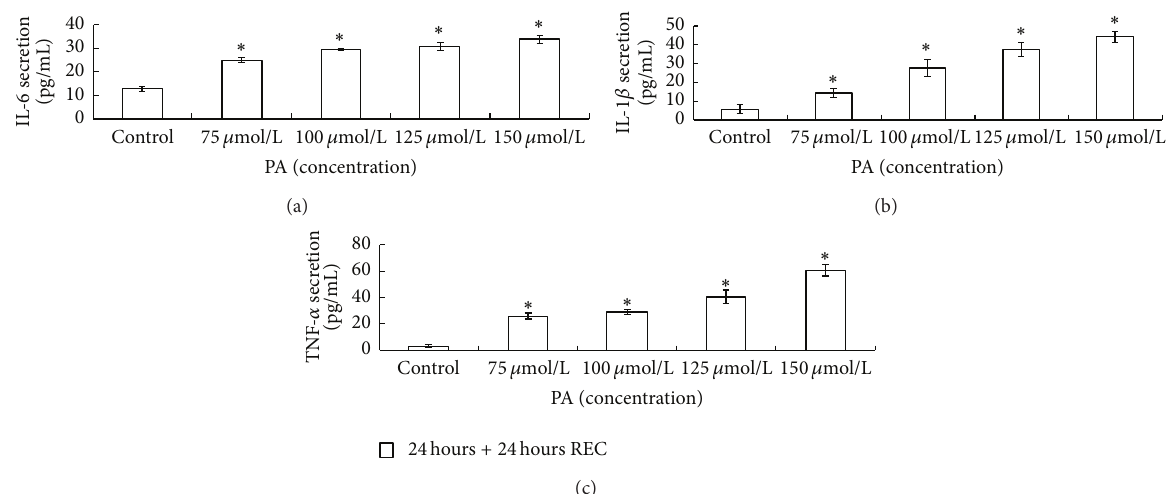
Figure 1: PA induces an upregulation of IL-6, IL-1 𝛽 , and TNF- 𝛼 secretion in HaCaT keratinocytes. HaCaT keratinocytes were untreated or treated with PA (75, 100, 125, and 150 𝜇 mol/L) for 24 hours under serum-free conditions, and collected 24 hours after PA depletion. IL-6 (a), IL-1 𝛽 (b), and TNF- 𝛼 (c) releases were determined by ELISA kits. Results are expressed as average mean of protein concentration (pg/mL) ± SD and represent the mean of three experiments in duplicate. Asterisks ( ∗ ) indicate significant differences of 𝑃 < 0.05 , respectively, between the PA-treated groups and nontreated group.